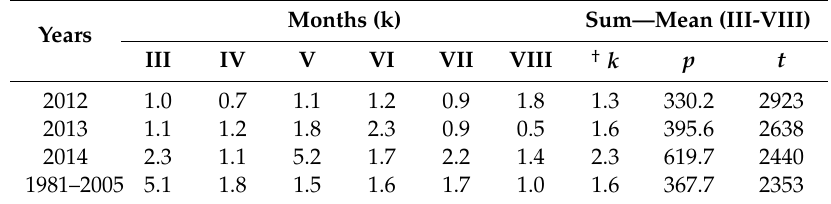
Table 1. The meteorological conditions (Meteorological Station in Zamo´s´c). Months (k) Sum—Mean Years